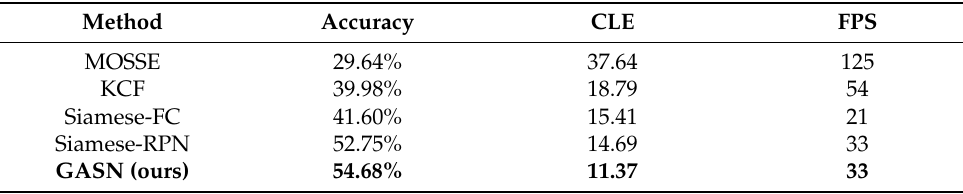
Table 4. Average tracking performance of real Video-SAR data.